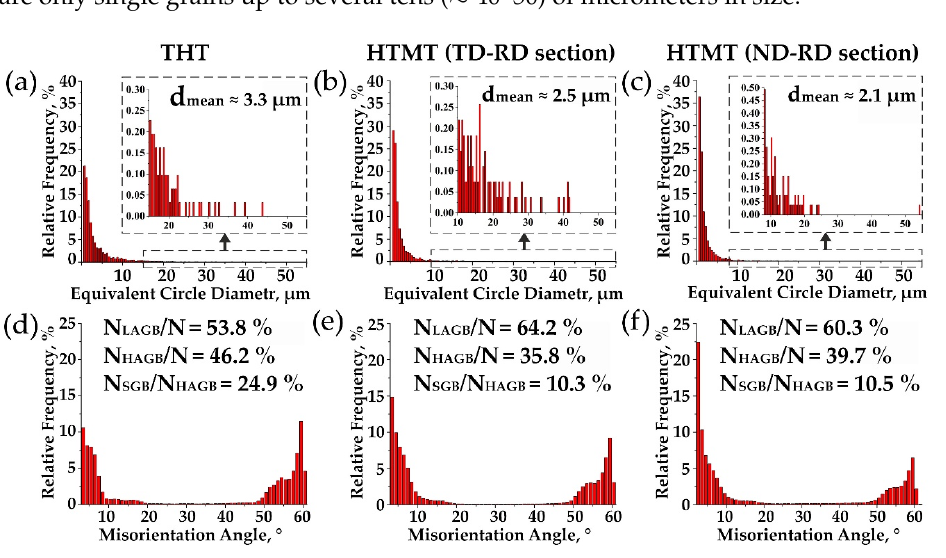
Figure 7. Grain misorientation distributions ( a – c ) and grain size distributions ( d – f ) after THT ( a , d ), HTMT in the section parallel to the rolling plane (TD ‐ RD section) ( b , e ), and in the cross section (ND ‐ RD section) ( с ,f ). NLAGB/N, NHAGB/N, NSGB/NHAGB—fraction of low ‐ angle, high ‐ angle, and special boundaries ( Σ 3), respectively.